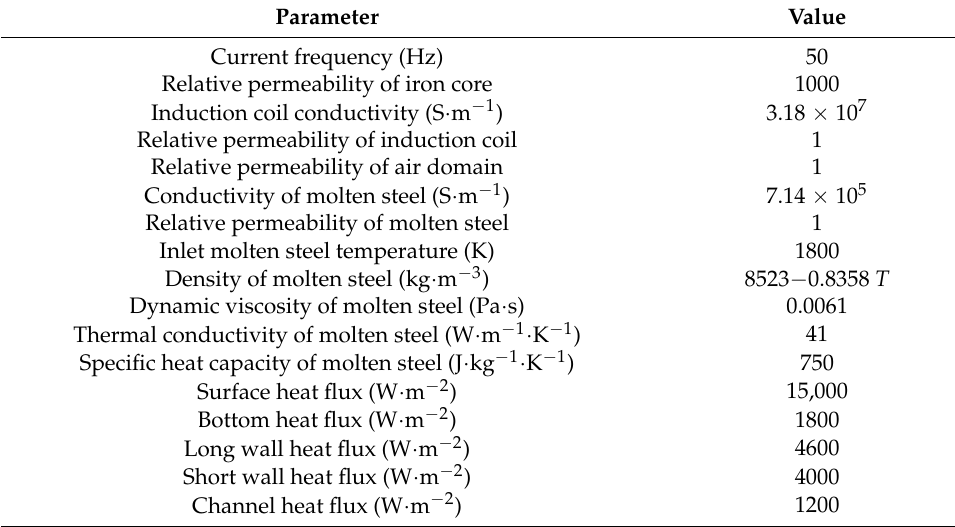
Table 3. Numerical simulation calculation parameters [22,23,29,34]. Parameter